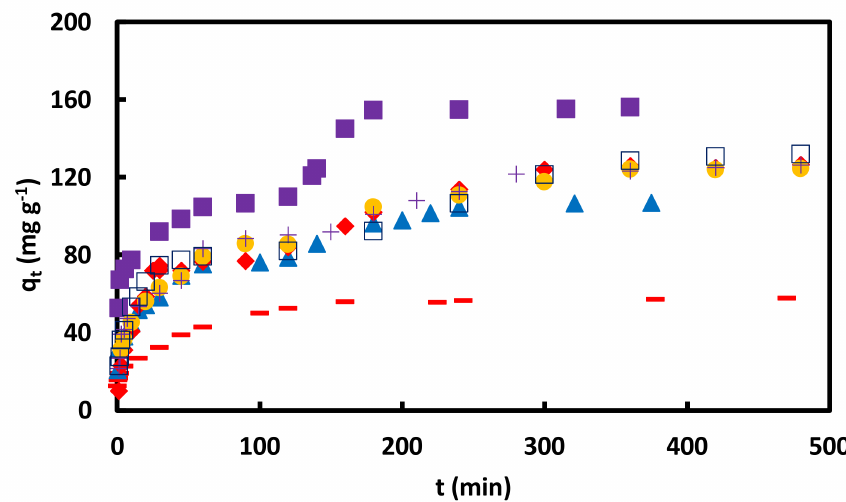
Figure 9. q t versus t for adsorption of CR on GO/PAMAM nanocomposite in + water, − 0.1 M NaCl, pH = 10, (cid:7) pH = 11, (cid:3) pH = 12 and (cid:78) pH = 13 solutions in 0.05 mM CR and at 318 K and 100 rpm.